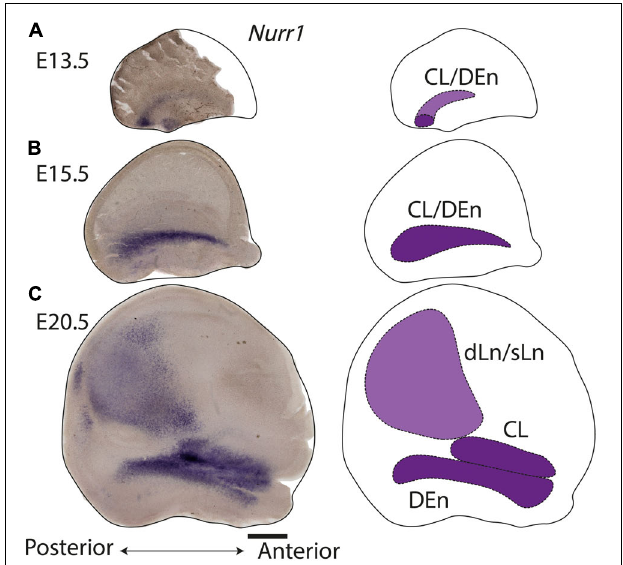
FIGURE 14 | Overview of claustrum development. Flattened cortex and schematic diagram of Nurr1 expression by in situ in E13.5 (A) , E15.5 (B) , and E20.5 (C) . One hemisphere was flattened and sectioned into 100 µ m sections. Multiple sections were overlayed in panels (B,C) . Scale bar in panel (A) = 1